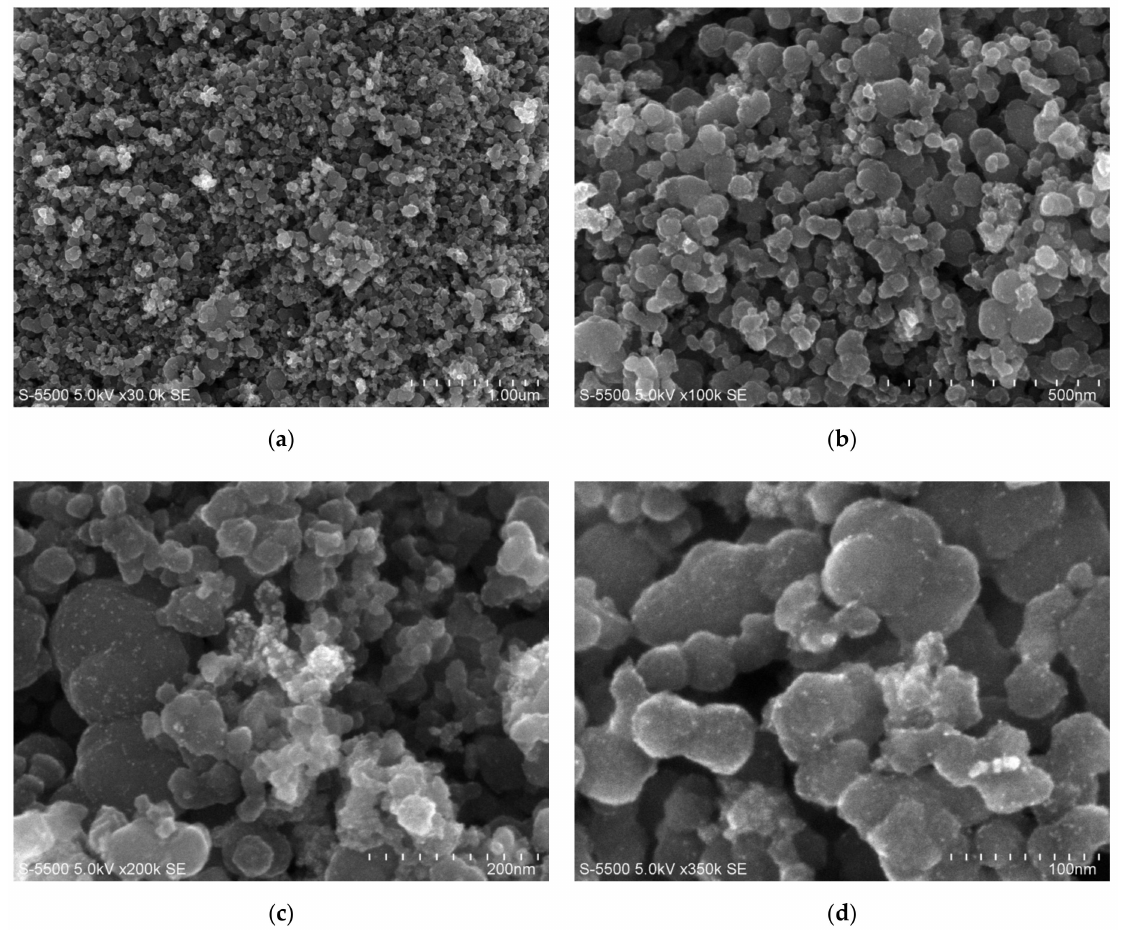
Figure 4. Scanning electron micrographs of the OsRu electrocatalyst synthesized at 180 ◦ C by microwave radiation in 1,2-dichlorobenzene, at ( a ) 30 × , ( b ) 100 × , ( c ) 200 × and ( d ) 350 ×